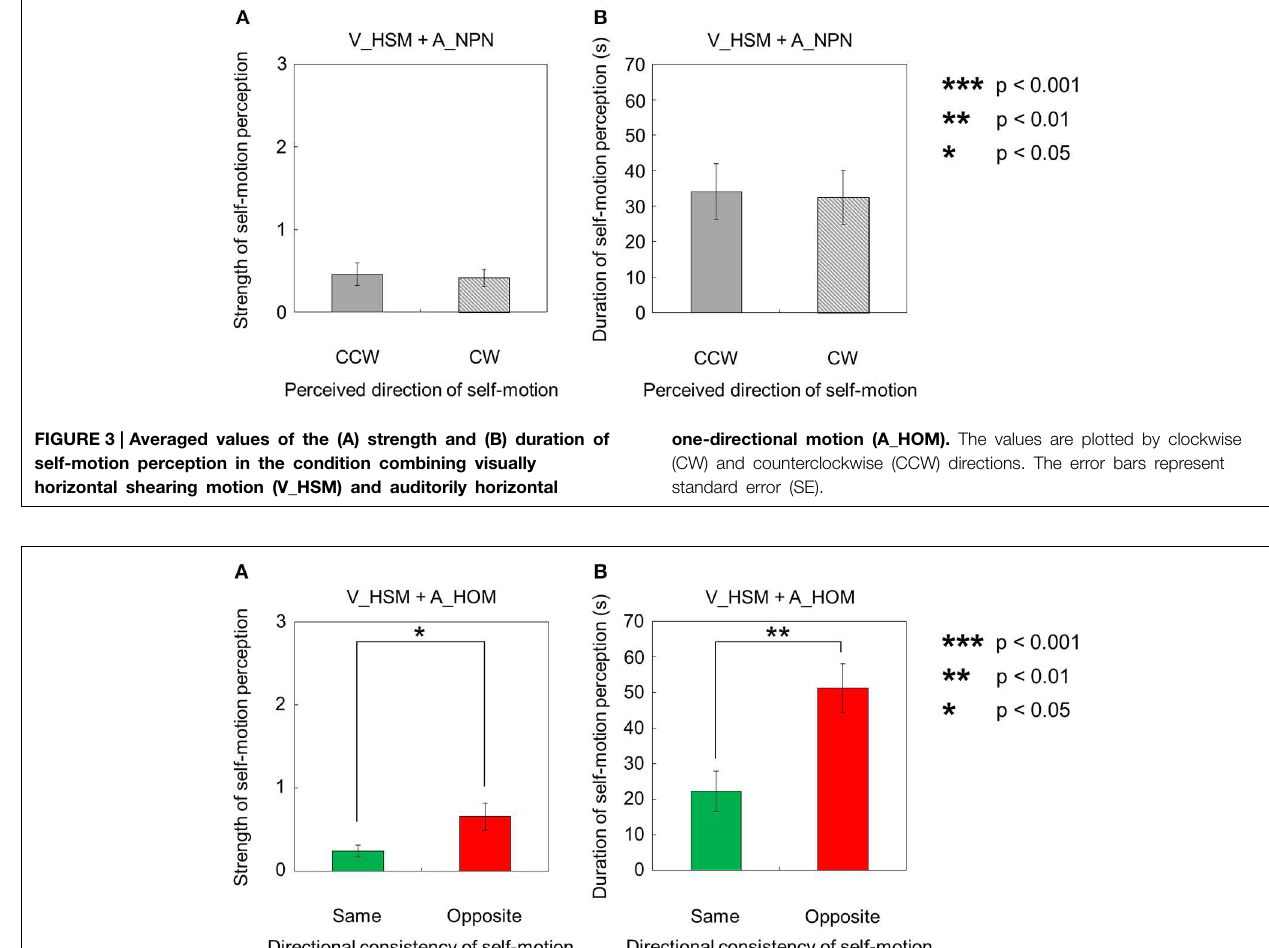
FIGURE 4 | Averaged values of the (A) strength and (B) duration of self-motion perception in the condition combining visually horizontal shearing motion (V_HSM) and no-auditory-stimulus